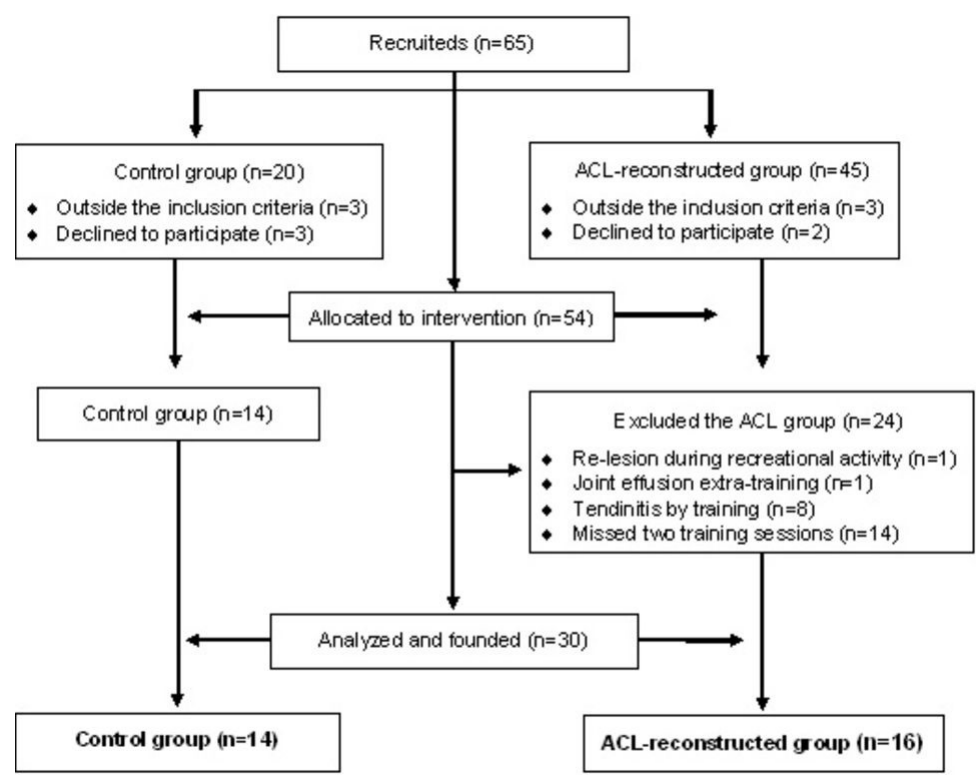
Figure 1. Flow diagram of the sample (ACL-reconstructed and control